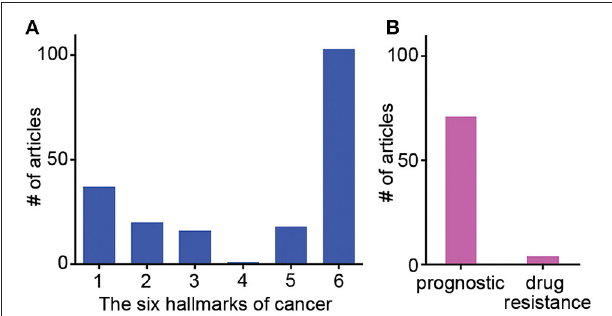
FIGURE 1 | Frequency of studies published showing ECM gene influences on specific hallmarks of cancer, patient prognostics and drug resistance. Results of meta-review survey depicting (A) the frequency of publications showing individual ECM-related genes influencing specific hallmarks of cancer and (B) the frequency of publications reporting ECM-related genes as a tool for patient prognostic determinations and specific drug